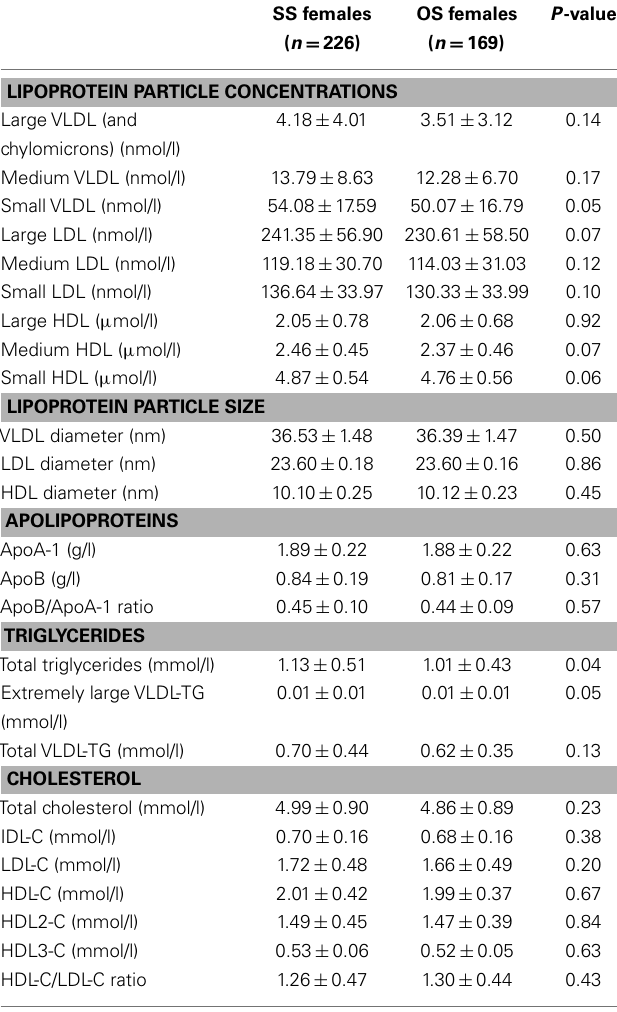
Table 2 | Serum lipid and lipoprotein profile for females from same-sex (SS) and opposite-sex (OS) twin